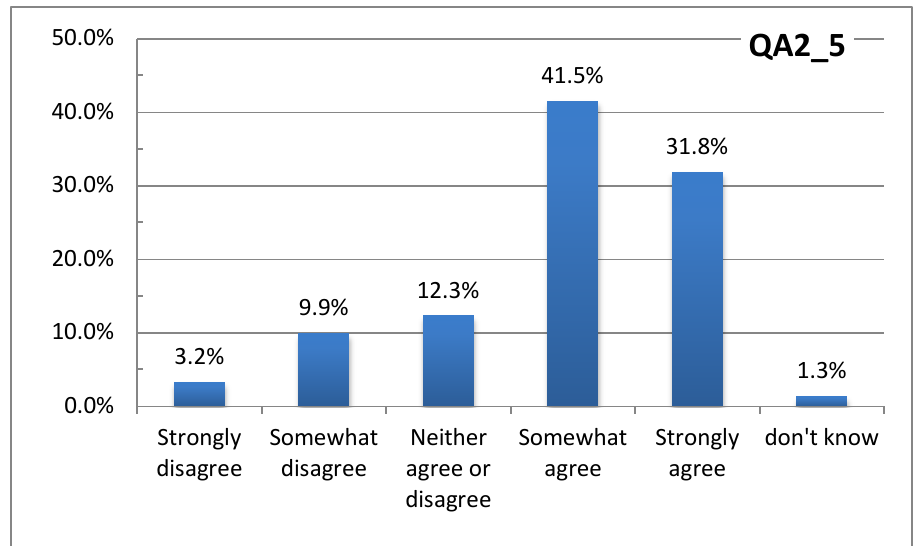
Figure 3. Respondent agreement or disagreement with the statement: “Everyone is at risk of illness or even death during heat